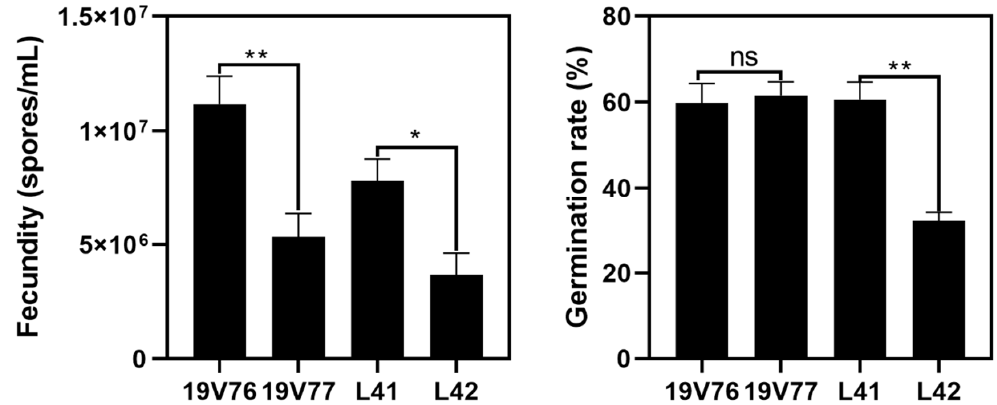
Figure 3. Fecundity (spores / mL) and germination rate (%) for the four tested V. dahliae isolates on